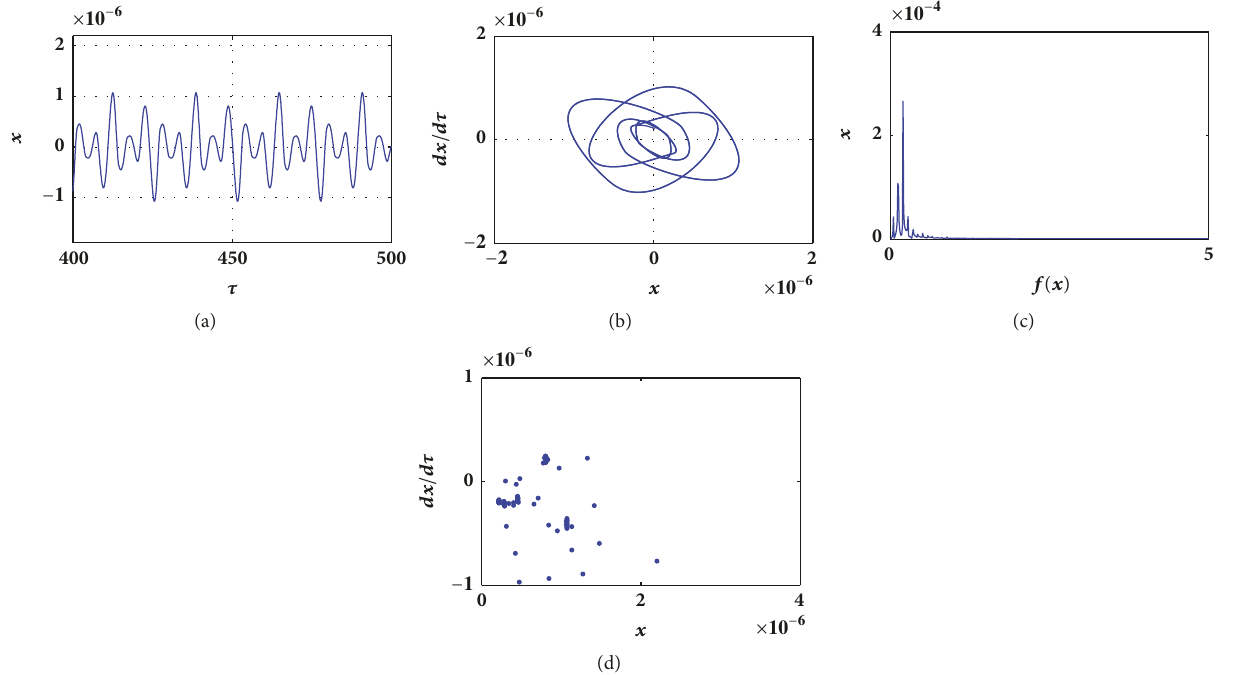
Figure 6: The time history, the phase diagram, spectrum, and the Poincar´e section of the system (6) for 𝜀 = 0.653 , 𝑄 = 1 .